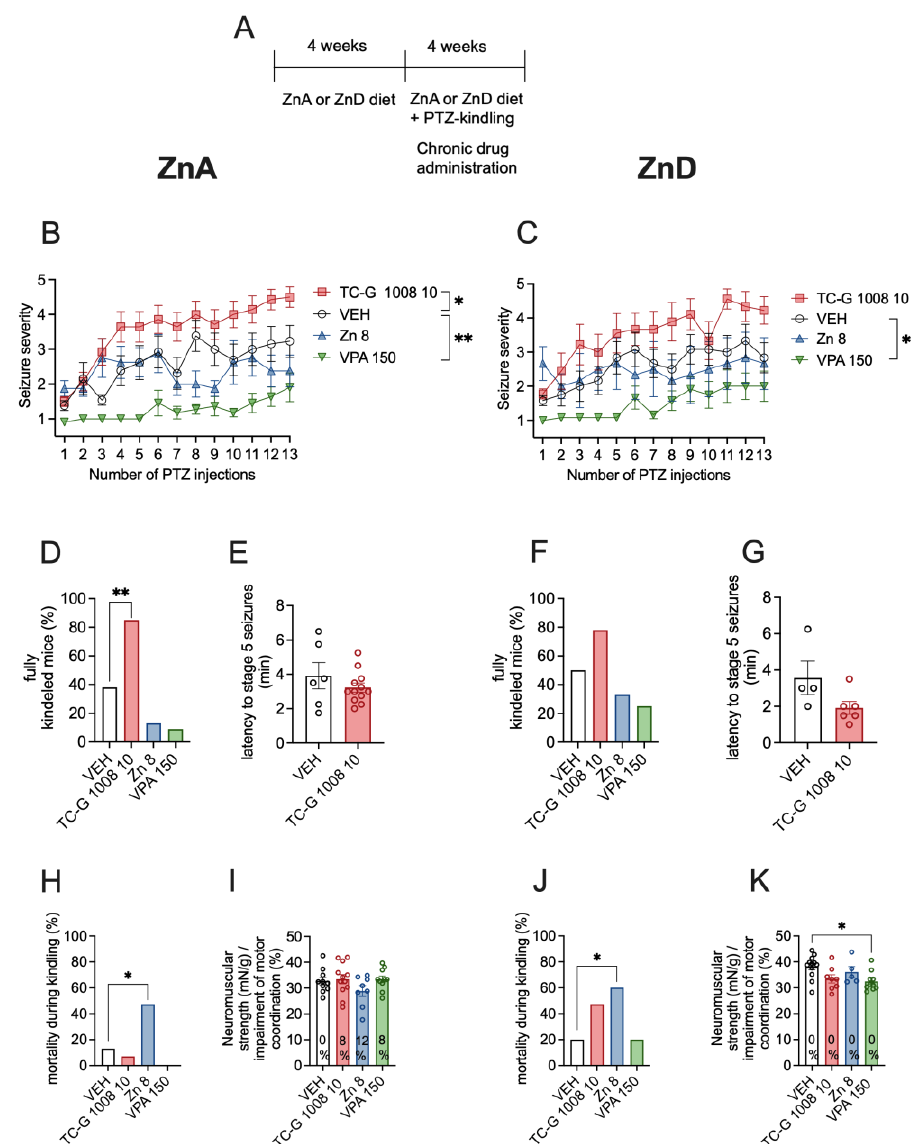
Figure 4. Chronic effects of TC-G 1008 (10 mg/kg), ZnCl 2 (8 mg Zn/kg), or VPA (150 mg/kg)